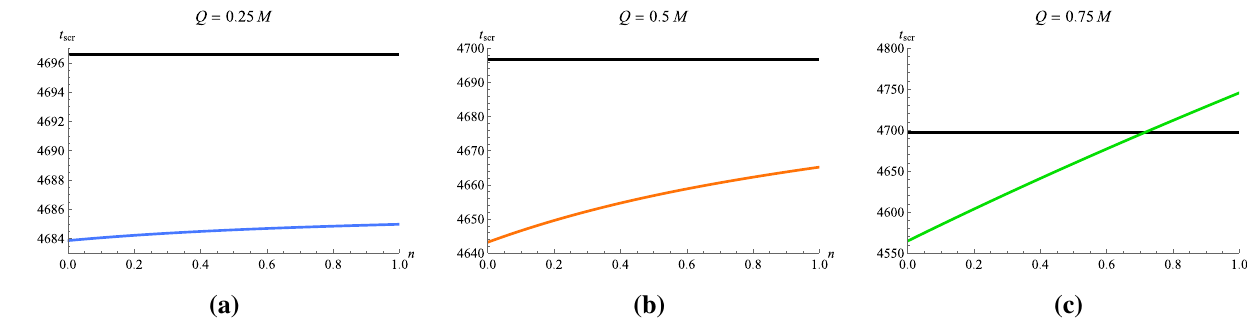
Fig. 6 The zoomed plots for Fig. 4c. The black line represents the scrambling time of Schwarzschild black holes